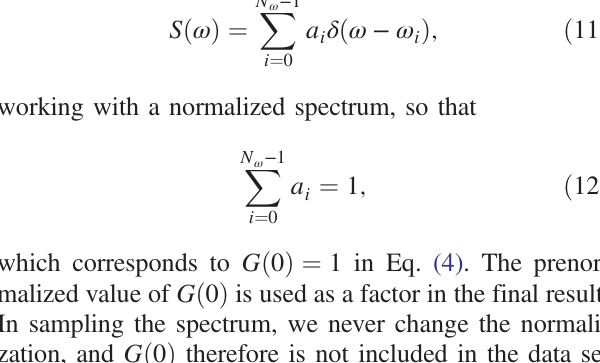
in the continuum (or, in i for i ∀ i > 0 i